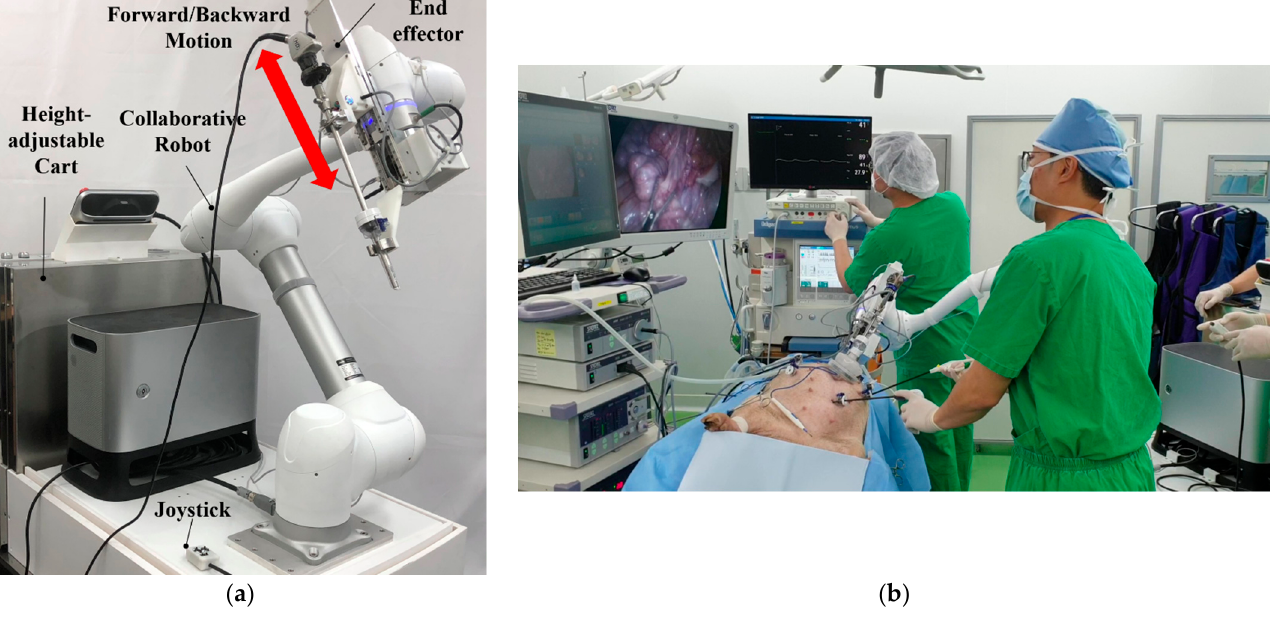
Figure 1. The surgical assistant robot: ( a ) prototype with end effector; ( b ) animal experiments.